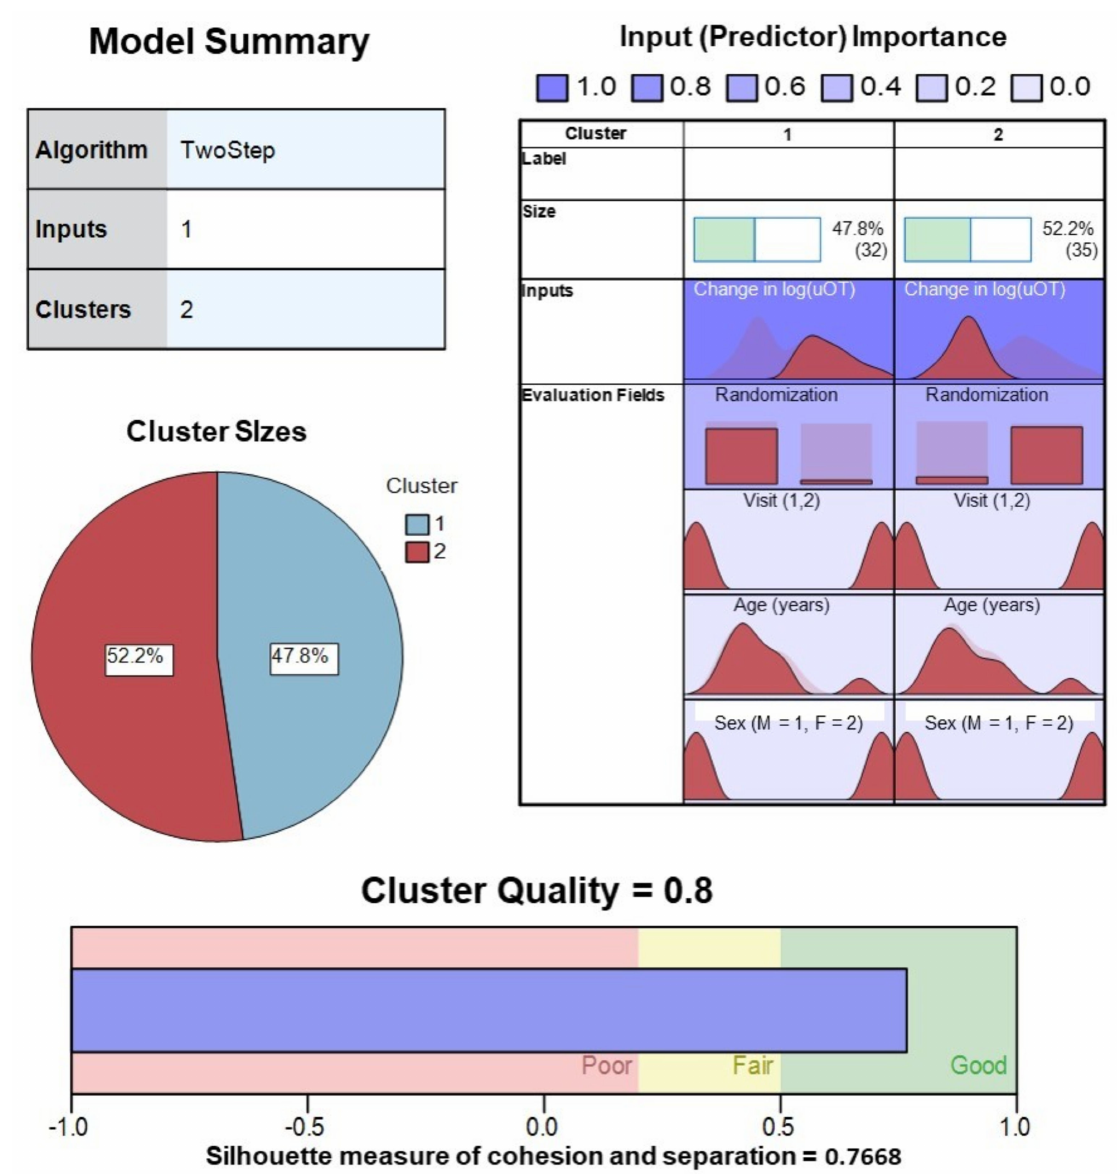
Figure 4. Model summary and cluster quality of two-step cluster analysis of pre–post-drug ad- ministration sampling of urine oxytocin from all participants (ASD, AN, and HC). Change in log transformed values of uOT, as well as Randomization Group, visit, age, sex, were evaluated for contribution (predictor importance) to the final solution. Good cluster cohesion and separation for the 2-cluster solution was driven largely by mean changes in log(uOT), further verifying the accuracy of our blinded uOT